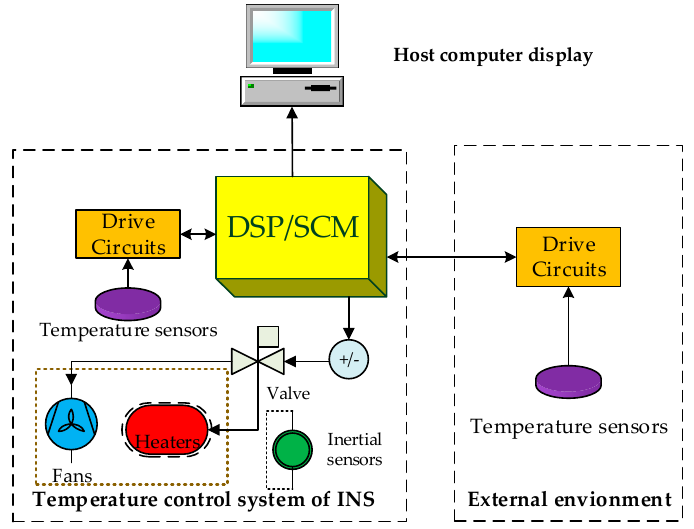
Figure 1. Platform of the temperature control system hardware.